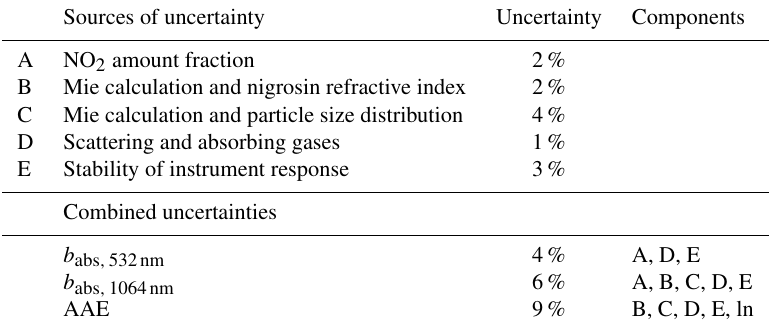
Table 4. The sources of uncertainty for PTAAM-2 λ measurements and combined standard uncertainties ( k = 1) for obtaining absorption coefficients and absorption Ångström exponent (AAE). Combined uncertainties were calculated using independent uncertainty